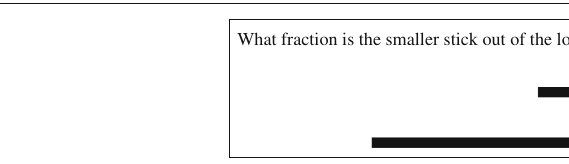
Fig. 4 Example of a task used to elicit a student ’ s partitive unit fraction